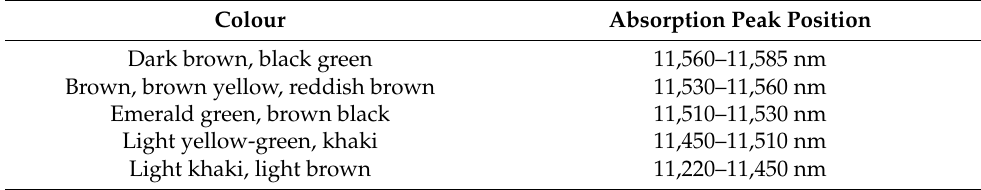
Table 1. Relationship between garnet colour and spectral characteristic value. Colour Absorption Peak Position Dark brown, black green 11,560–11,585 nm Brown, brown yellow, reddish brown 11,530–11,560 nm Emerald green, brown black 11,510–11,530 nm Light yellow-green,